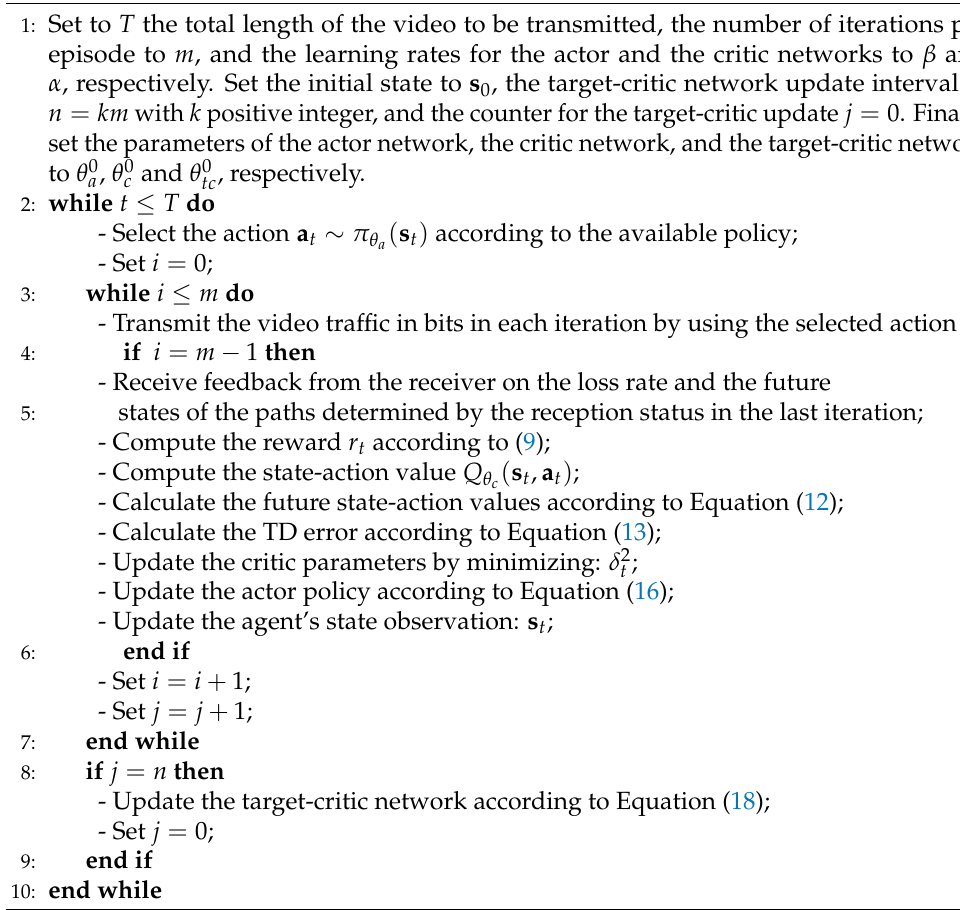
Algorithm 1 The training procedure for the AC-DRL agent for traffic